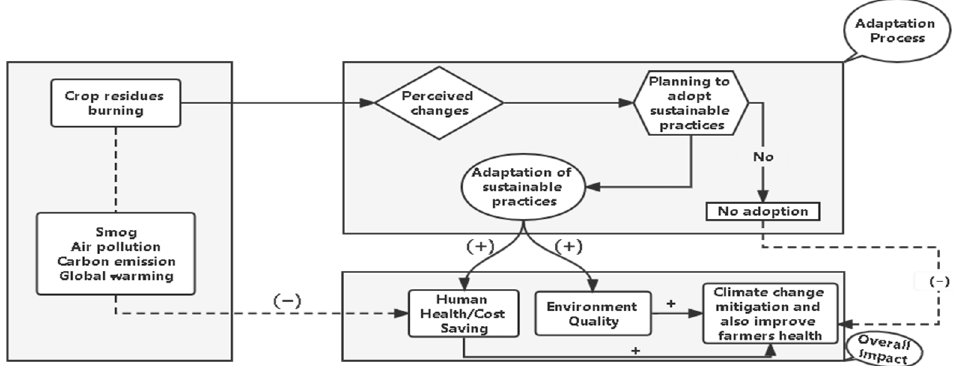
Figure 3. Conceptual framework.